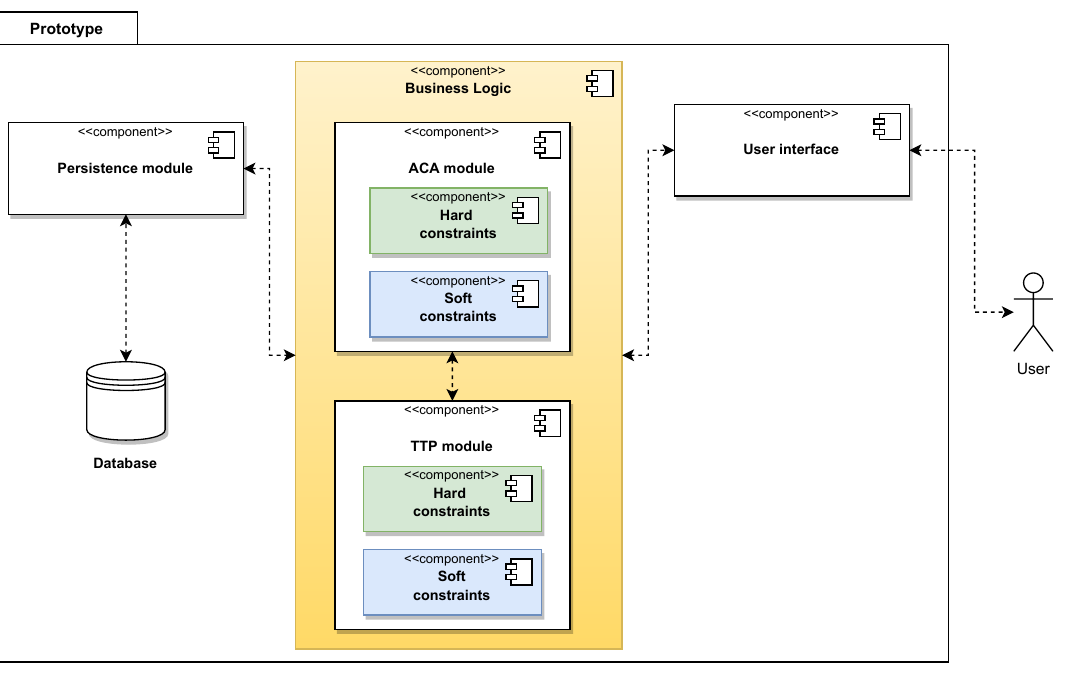
Figure 8. High-level